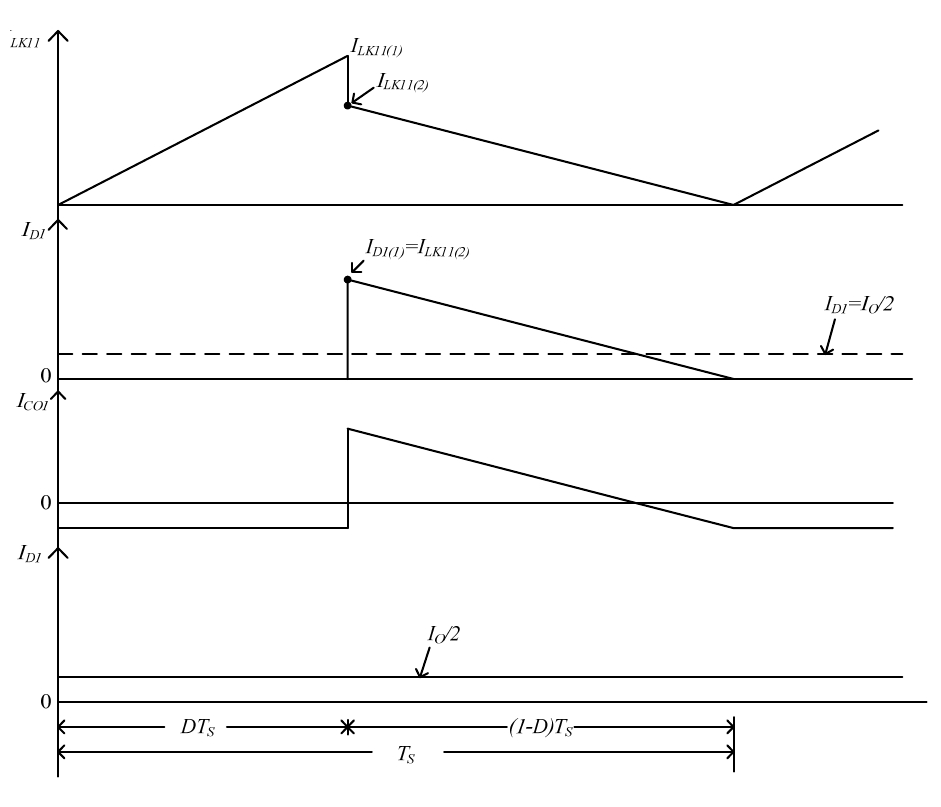
Figure 28. According to the previously assumed conditions, the equivalent circuit of the output